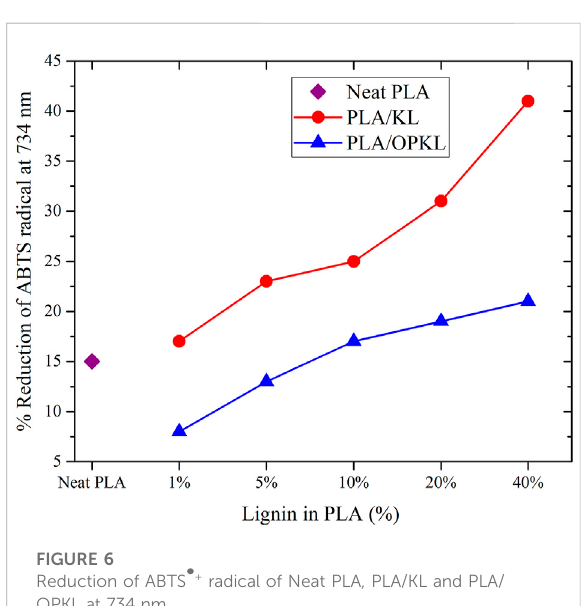
(cid:129) + radical of Neat PLA, PLA/KL and PLA/